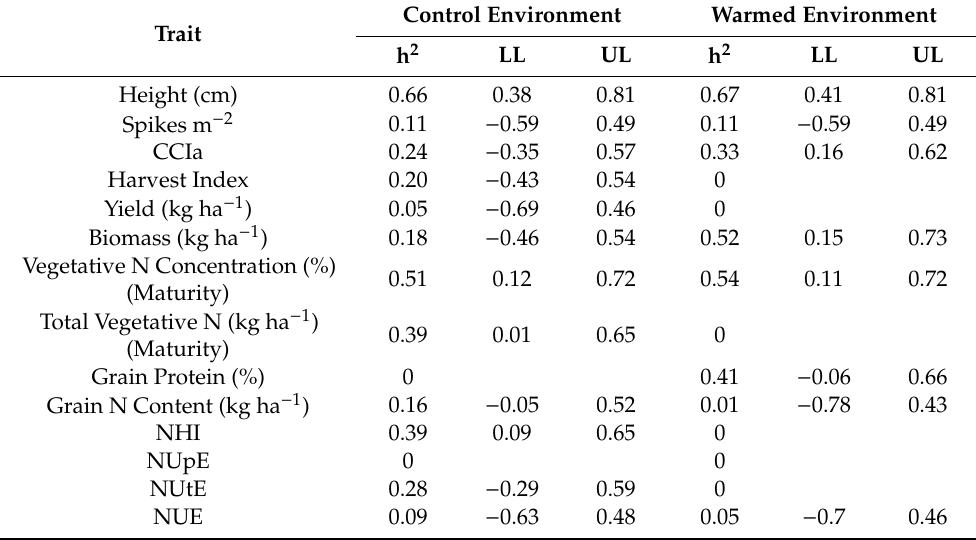
Table 8. Heritability estimates † and 90% confidence intervals from a SRW wheat genotype panel grown in control and passively warmed environments, Lexington, KY, 2015–2016. Control Trait